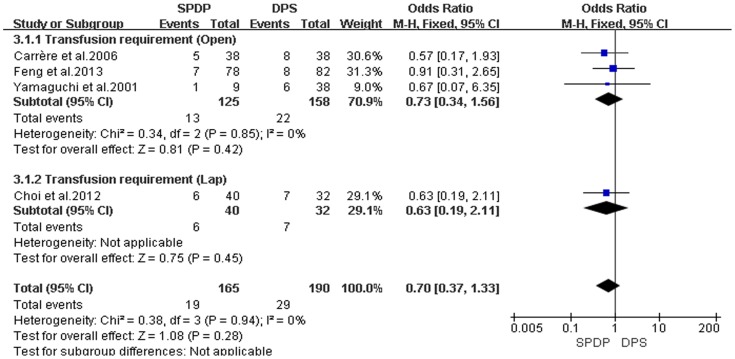
Transfusion requirement (IV, Inverse variance, M-H, Mantel-Haenszel, CI, Confidence Interval; SD, Standard deviation).